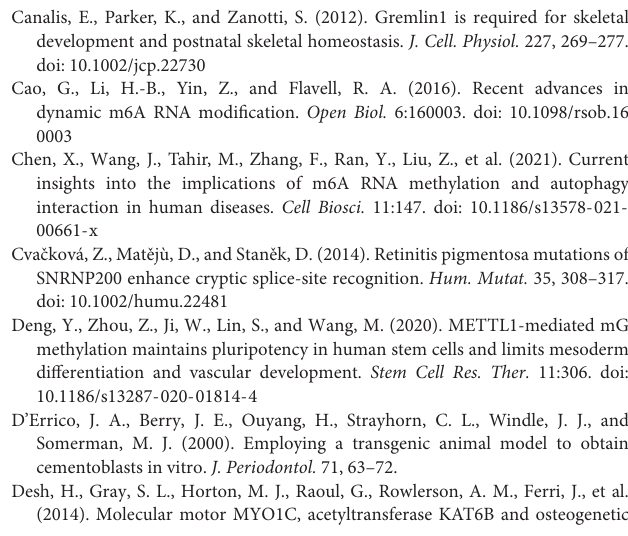
Supplementary Figure 1 | The gene expressions were detected by real-time RT-PCR. (A–C) There was no significant difference of the expression of GREM1 (A) , TRMT10C (B) , and METTL1 (C) in the miR-6807-5p inhibitor group compared with the control group. GAPDH was used as internal control. Student’s t -test was performed to determine statistical significance. All error bars represent the standard deviation ( n =